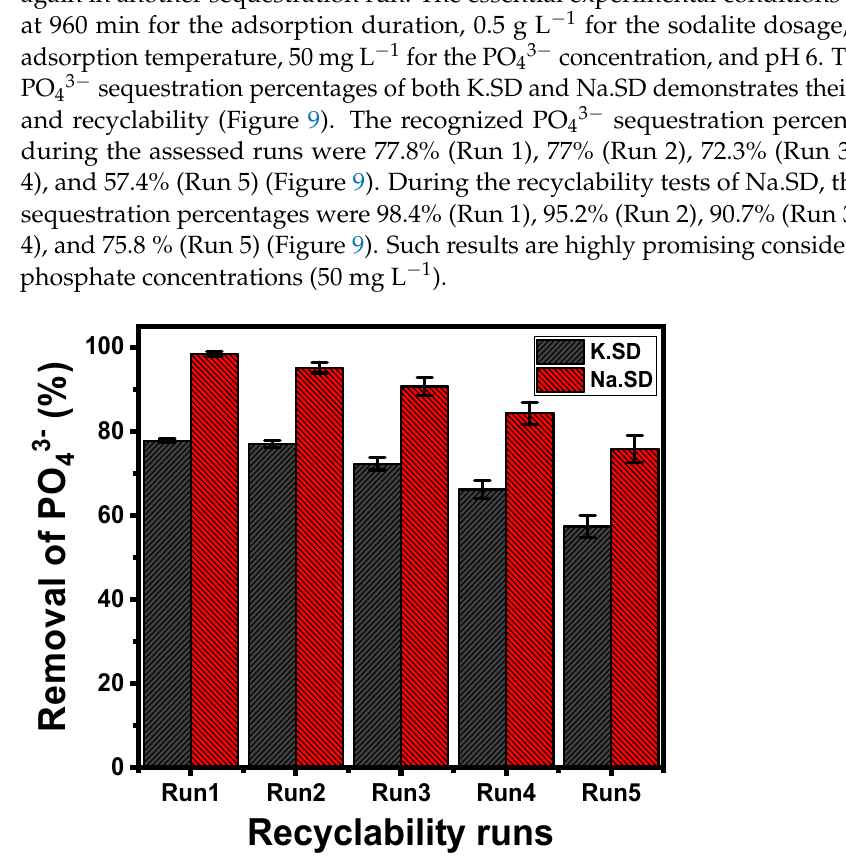
Figure 8. Fitting of the PO 43 − sequestration results with Van’t Hoff equation (pH 6, 100 mg L − 1 phos- phate concentration, 0.1 g L − 1 dosage, and 960 min adsorption duration).